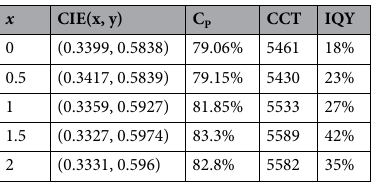
Table 1. Colour coordinates, colour purity, colour temperature, and internal quantum yield of KAlSiO 4 : 1.5 mol % Tb 3+ , x mol % Li + samples.